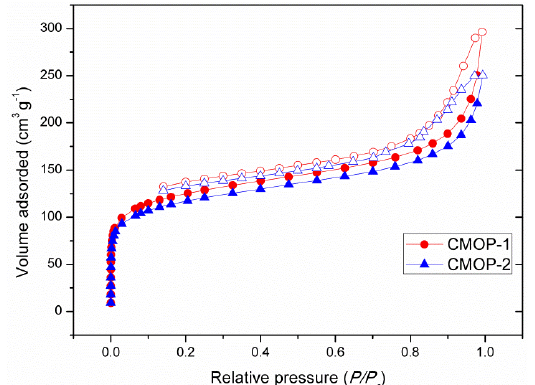
Figure 1. N 2 adsorption–desorption isotherm at 77 K (filled: adsorption; empty: desorption).